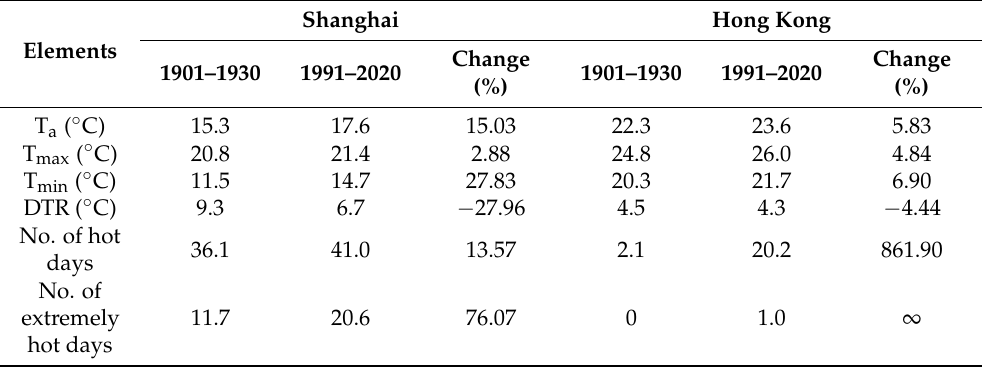
Table 2. Comparison of the statistic of temperature-related data for the Shanghai and Hong Kong observatories.